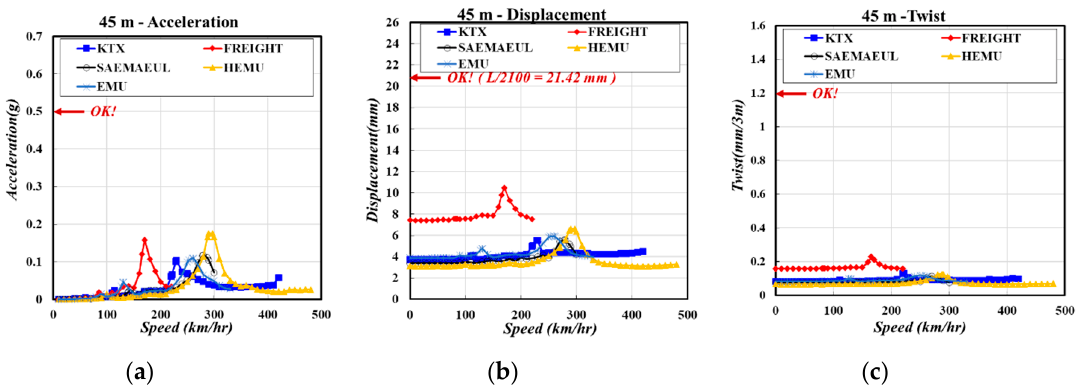
Figure 13. Moving load analysis results for span length of 45 m: ( a ) vertical acceleration response; ( b ) vertical displacement response; and ( c ) twist response.